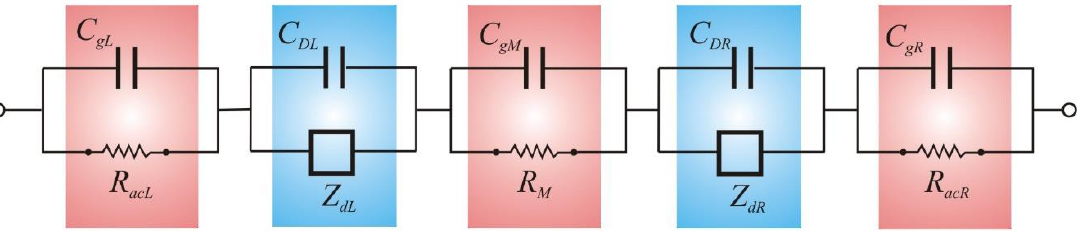
Figure 2. Equivalent electric circuit model of the impedance of an ion-exchange membrane system.